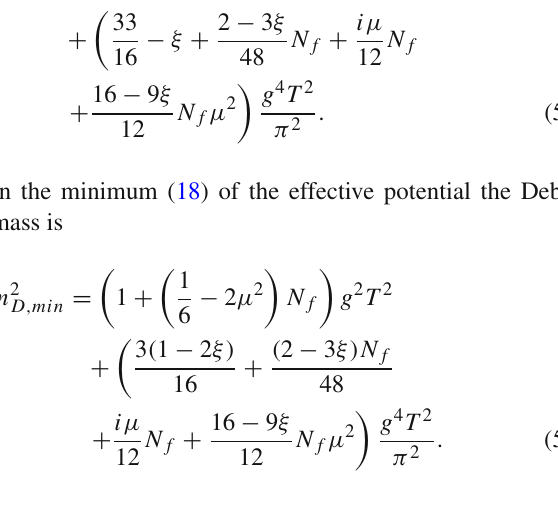
Fig. 4 The effective potential (49) in the minimum as function of ˜ μ for N f = 0 , 1 ,..., 5 (from top to bottom). The curves terminate